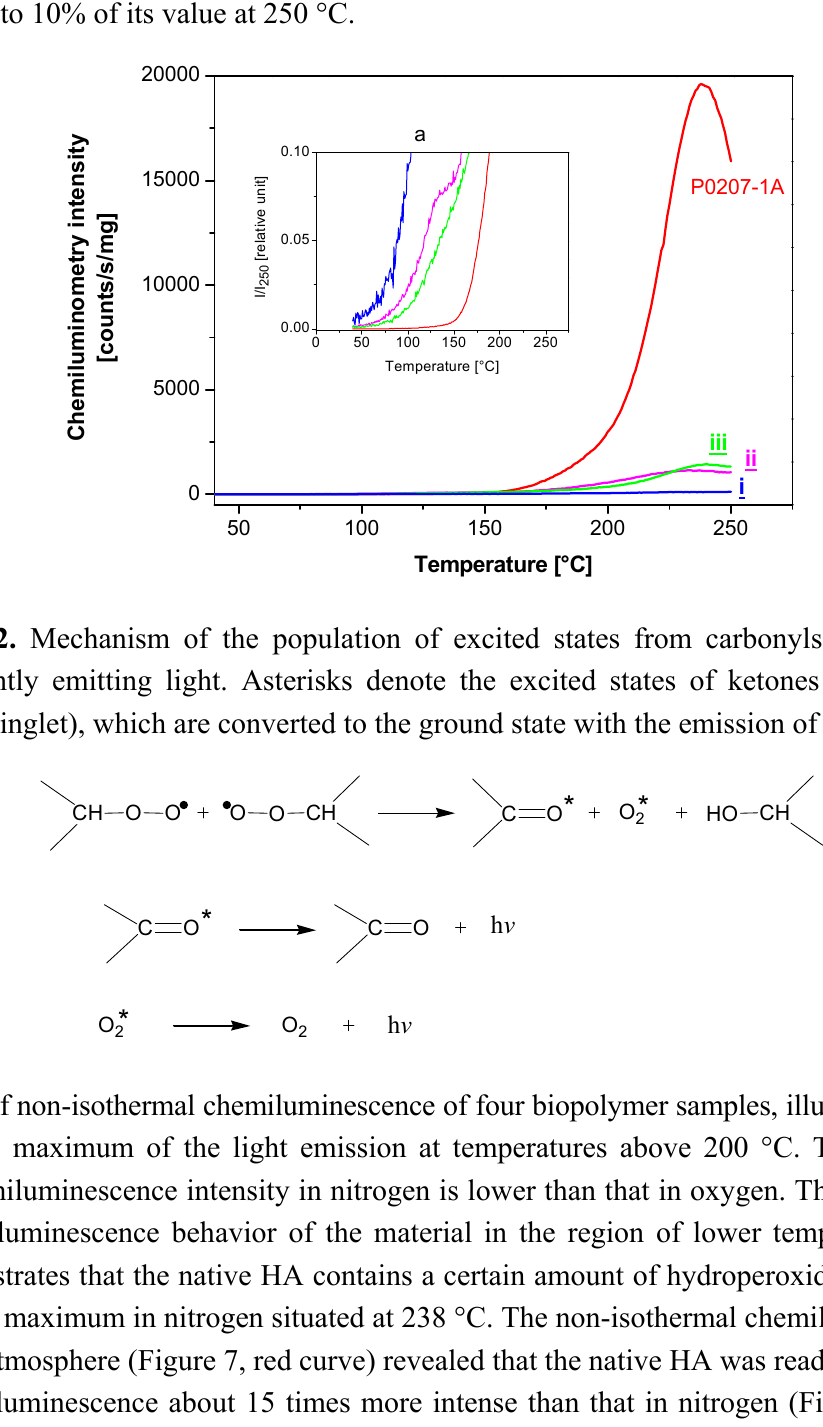
Figure 6. Non-isothermal chemiluminometry of four biopolymeric samples. The sample treatment was carried out in nitrogen. Native HA sample P0207-1A, recovered polymers prepared by treating native HA sample with WBOS without addition of bucillamine ( i ) and with addition of bucillamine in the system before the reaction onset ( ii ) and after 1 h ( iii ). The inserted plot ( a ) is a cross-section of the original runs where intensity of chemiluminescence is plotted to 10% of its value at 250 °C.